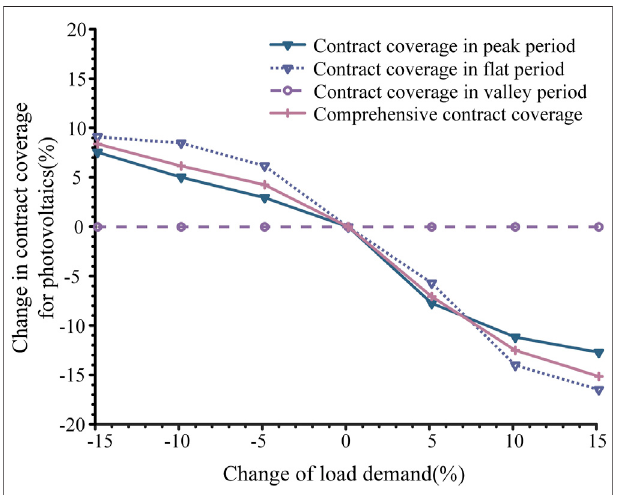
FIGURE 9 | Changes in CCR of wind turbines under different system load